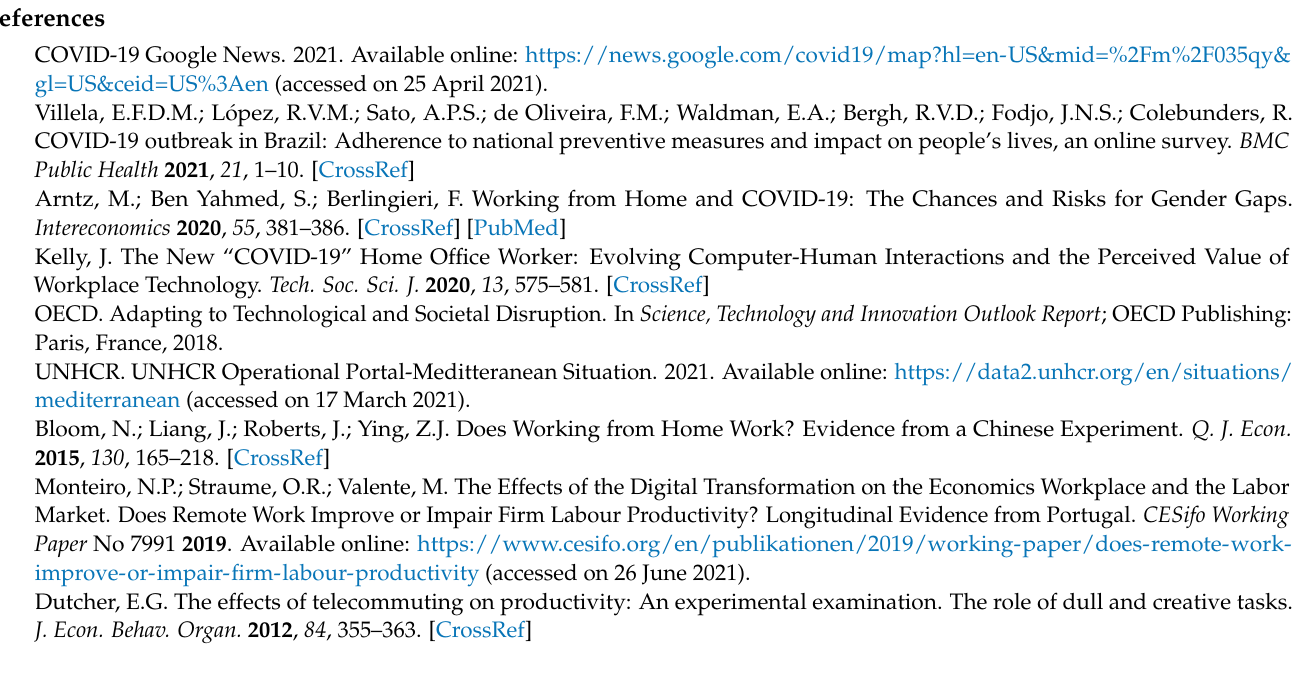
Table S4: How much income has been affected during crisis, broken down by educational level. Table S5: Adaptation to working from home versus age, Table S6: Attitude towards fulltime working from home vs. age, Table S7: Impact of lockdown on income in working sector, Table S8: Impact of lockdown on employment in working